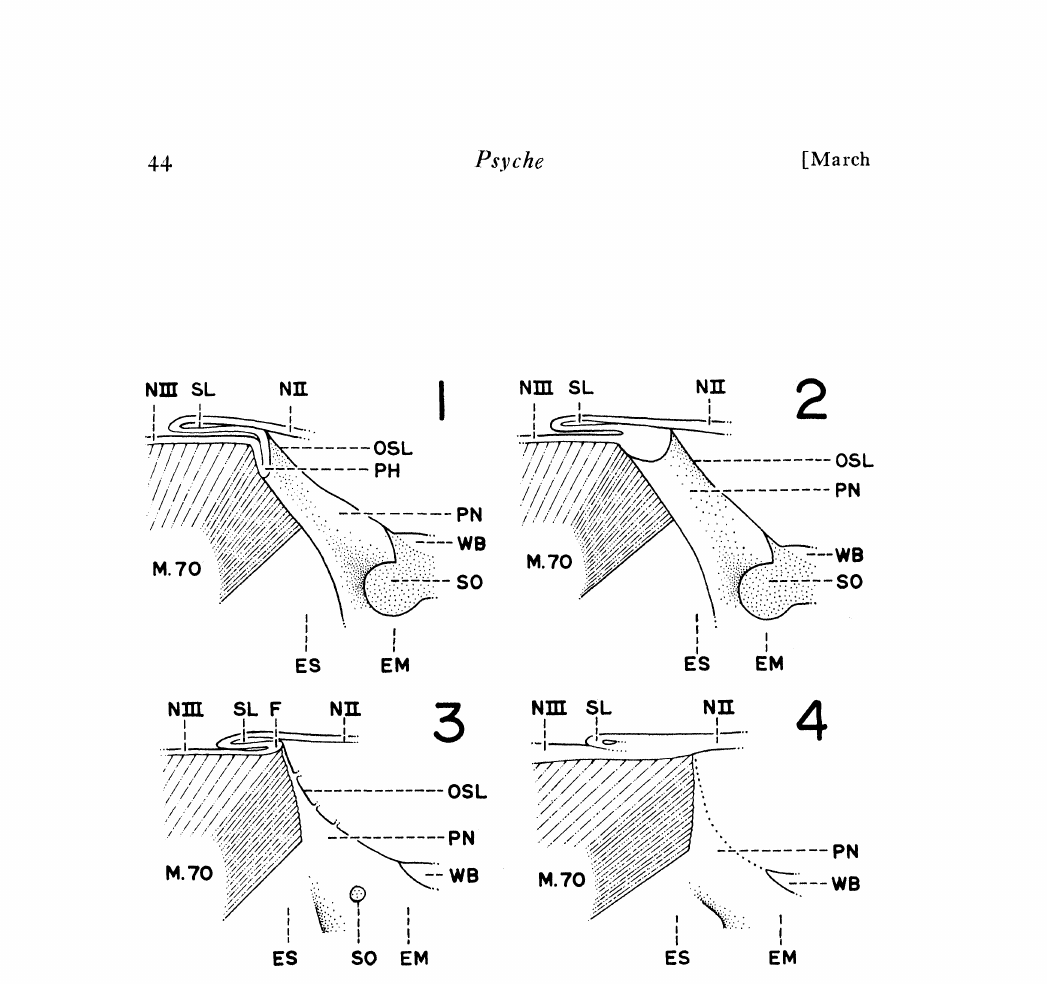
Figures 1-4, Diagrammatic internal views of dorsolateral intersegmental region of pterothorax in various adult Naucoridae. Left side of body has been cut parasagittally through terga (cut edge), between ventral phragmal process (not shown) and wingbase (WB). Fig. 1. Typical maeropterous Naueoridae (based on Pelocoris [emoratus). Fig. 2. Macropterous Crypho- cricos barozzii. Fig. 3. Newly-moulted mieropterous 6’. barozzii. Fig. 4. Older micropterous C. barozzii (dotted line indicates approximate position of opening into scutellar lobe, which is no longer